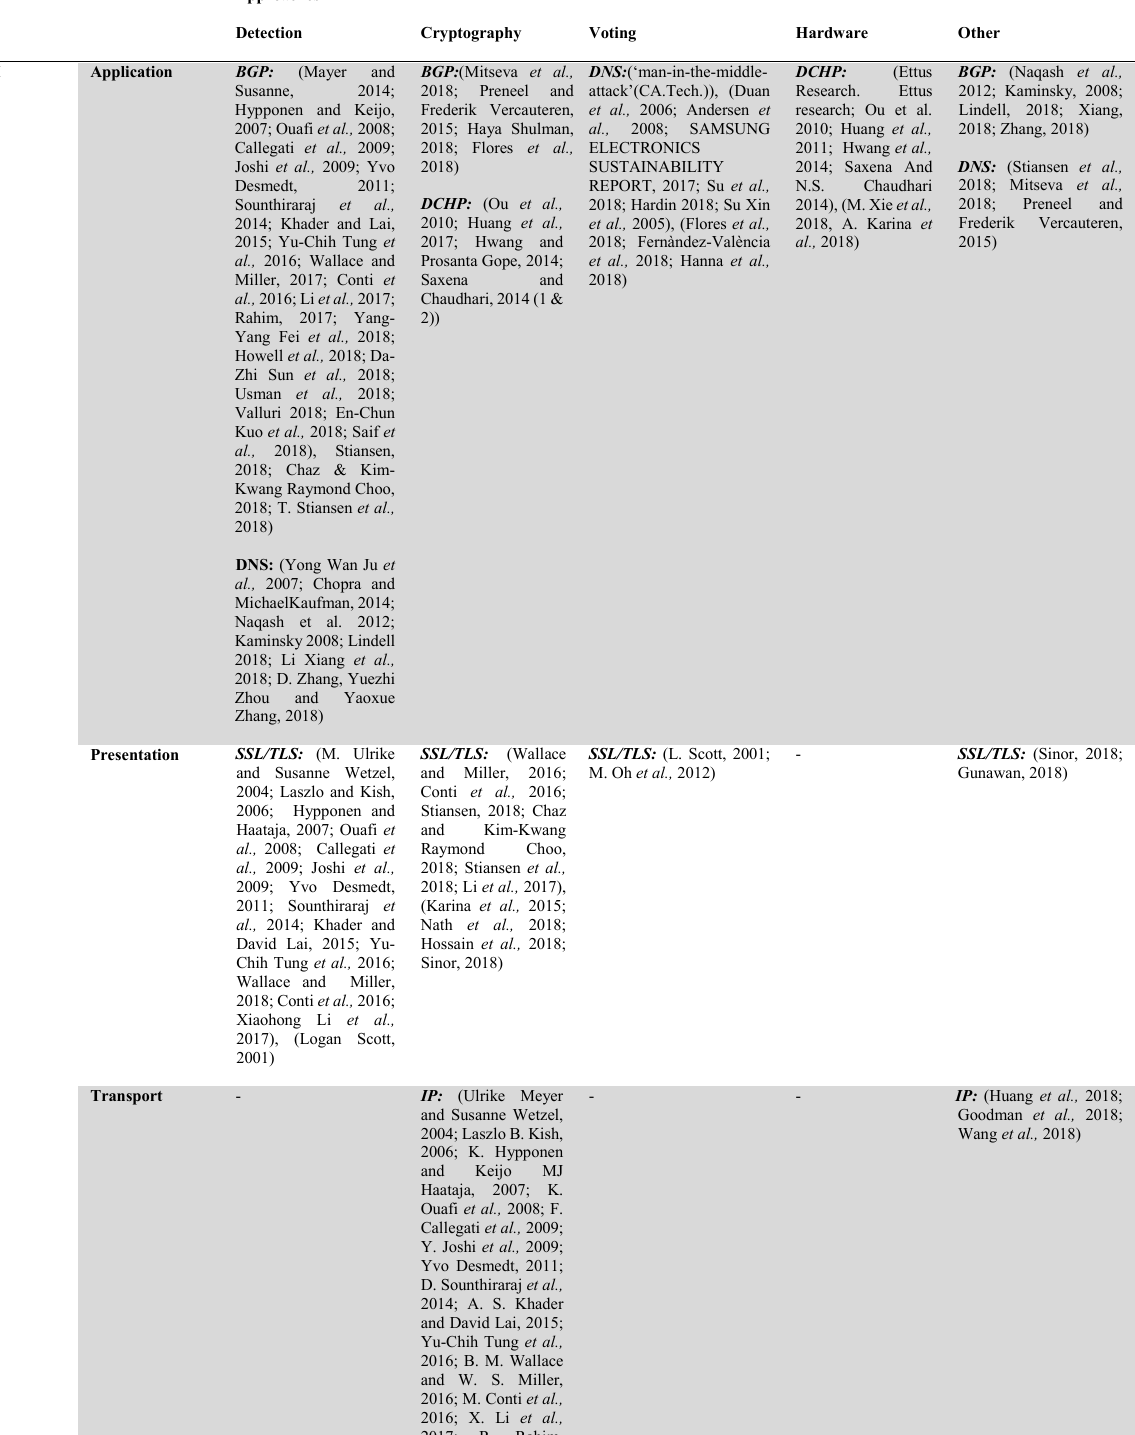
Various MITM prevention Mechanisms studied from